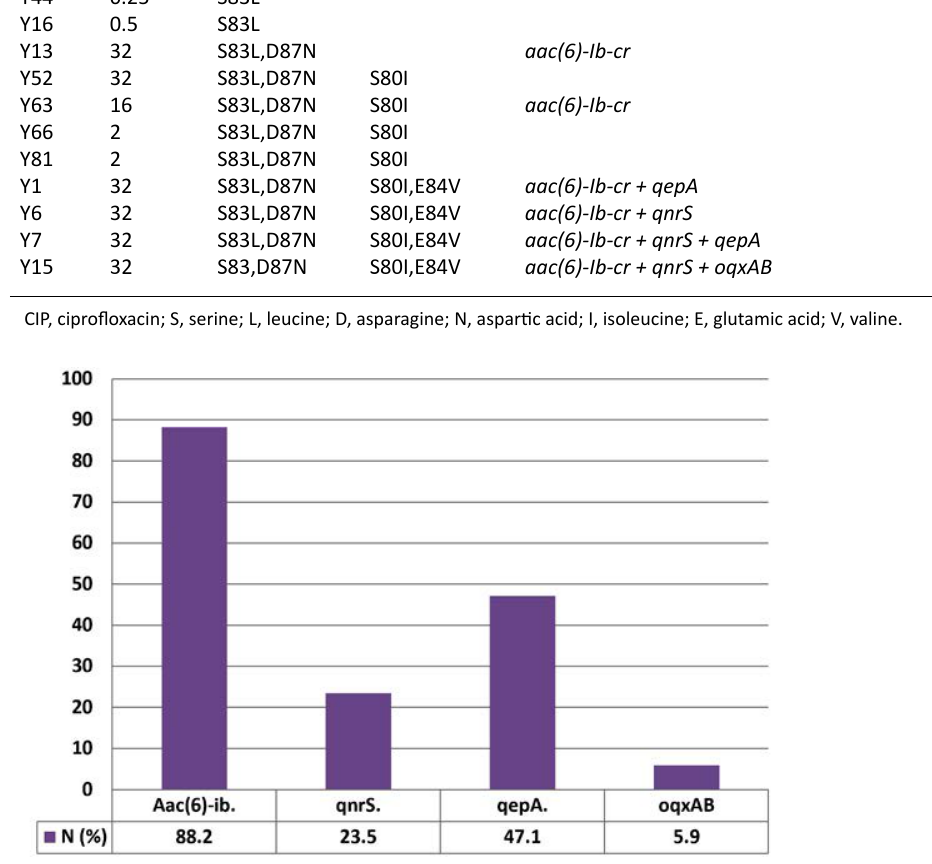
Fig. 2. Distribution of PMQR genes among nalidixic acid-resistant E.coli strains isolated from patients with UTIs (No. of isolates = 51).